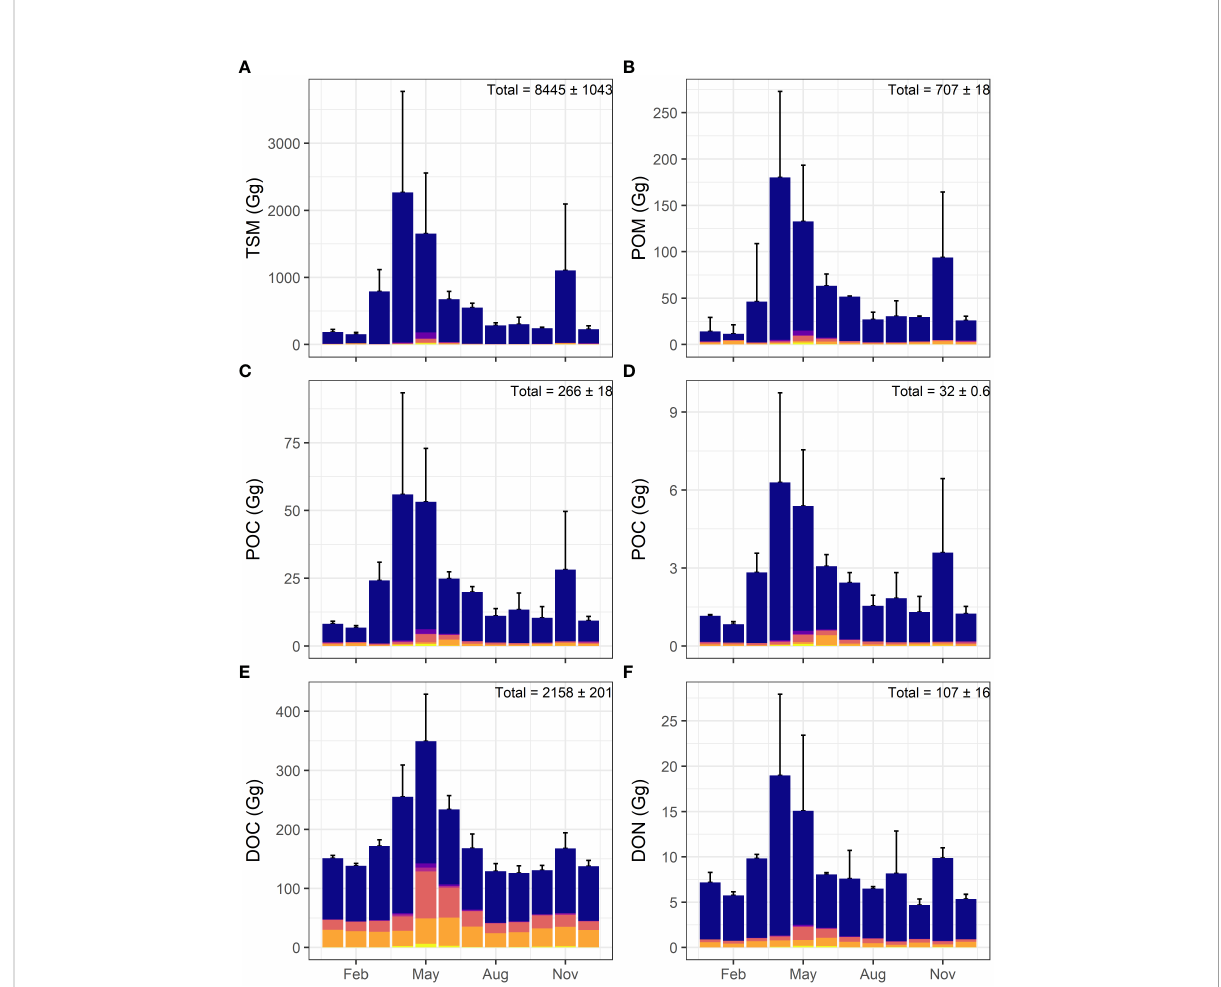
FIGURE 2 Stacked barplots of St. Lawrence estuary tributaries mean loadings (bars) and cumulative standard deviation (error bars) of (A) TSM, (B) POM, (C) POC, (D) PON, (E) DOC, and (F) DON for 2016 – 17. From top to bottom: blue = St. Lawrence River, purple = Northshore-USLE tributaries, fuchsia = Southshore-LSLE tributaries, coral = Saguenay River, orange = Northshore-LSLE tributaries, yellow = Southshore-LSLE